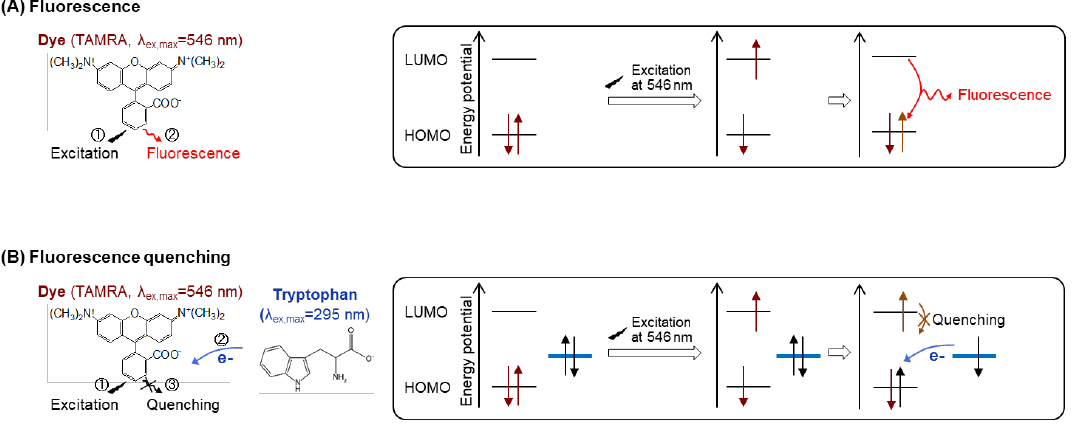
Figure1. Schematicrepresentationofthemechanismsof( A )fluorescenceand( B ) Figure 1. Schematic representation of the mechanisms of ( a ) fluorescence and ( b ) fluorescence quenching.